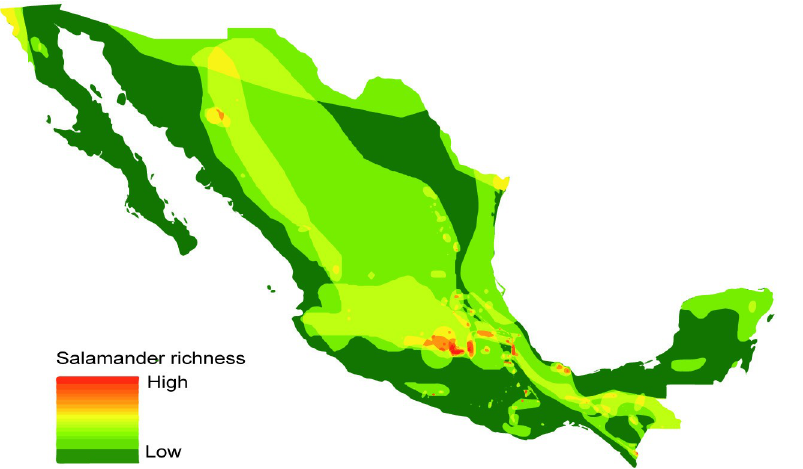
Fig 2. Map of salamander richness distribution in